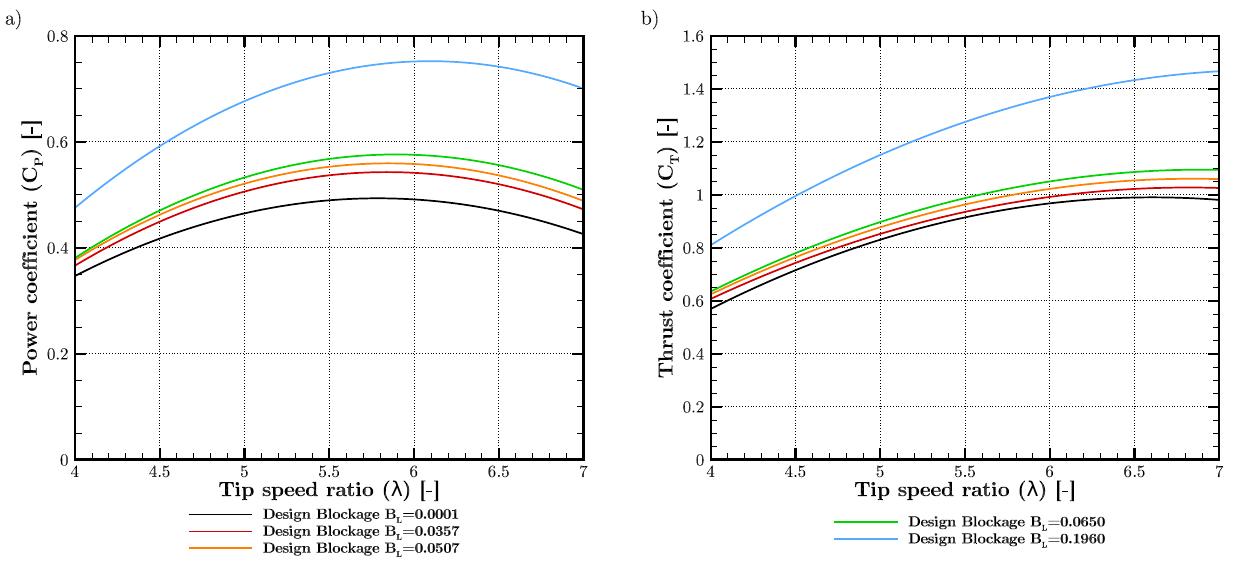
Fig. 3. Variation in (a) rotor power coefficient, C P , and (b) thrust coefficient, C T , with tip speed ratio λ for the five rotors designed for local blockage ratios B L = 0 . 0001 (black), B L = 0 . 0357 (red), B L = 0 . 0507 (orange), B L = 0 . 0650 (green), and B L = 0 . 1960 (blue), operating in their respective design blockage ratios.